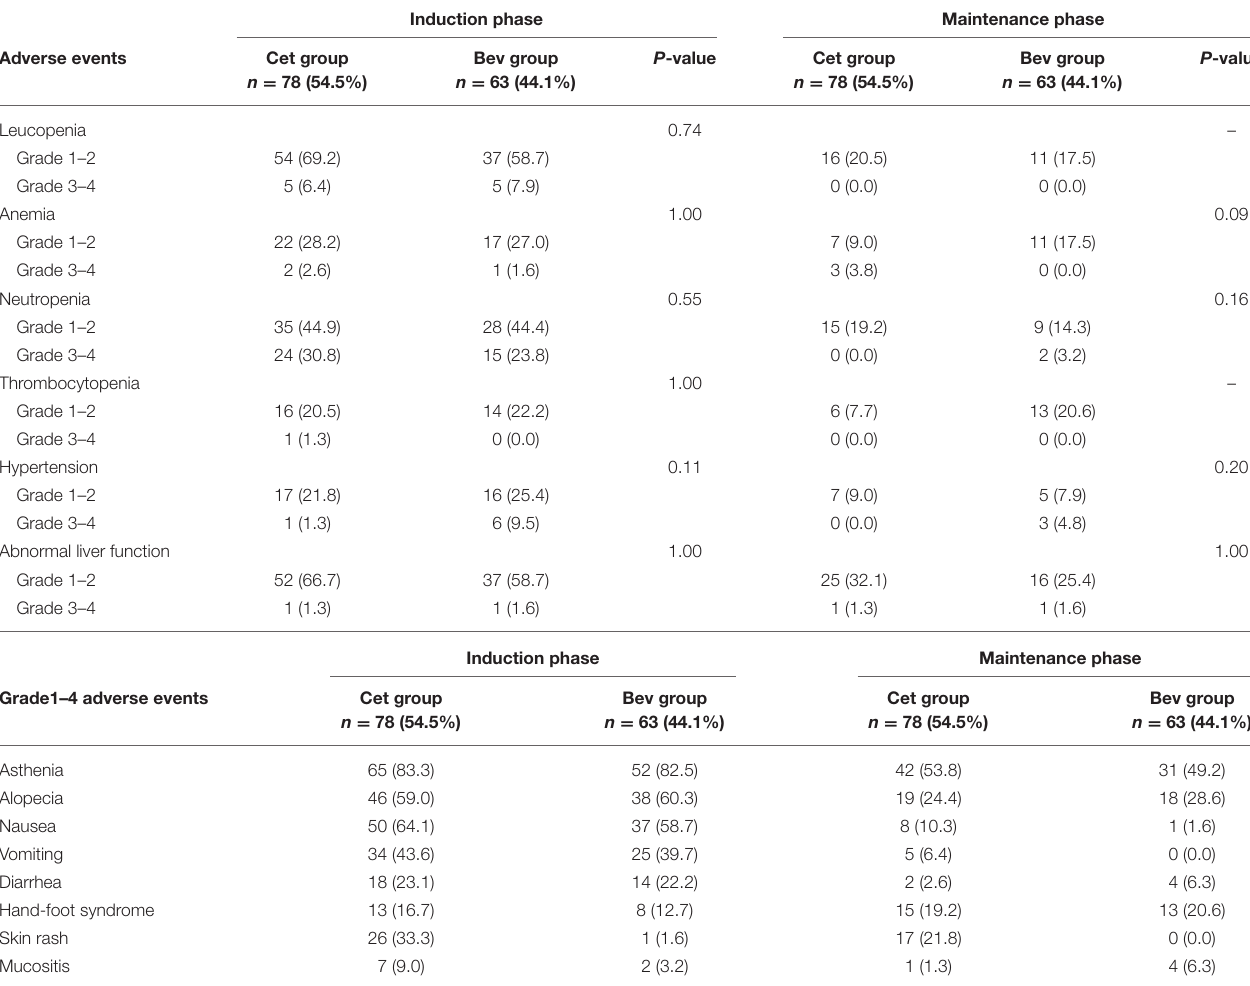
TABLE 5 | Adverse events considered relevant to treatment.